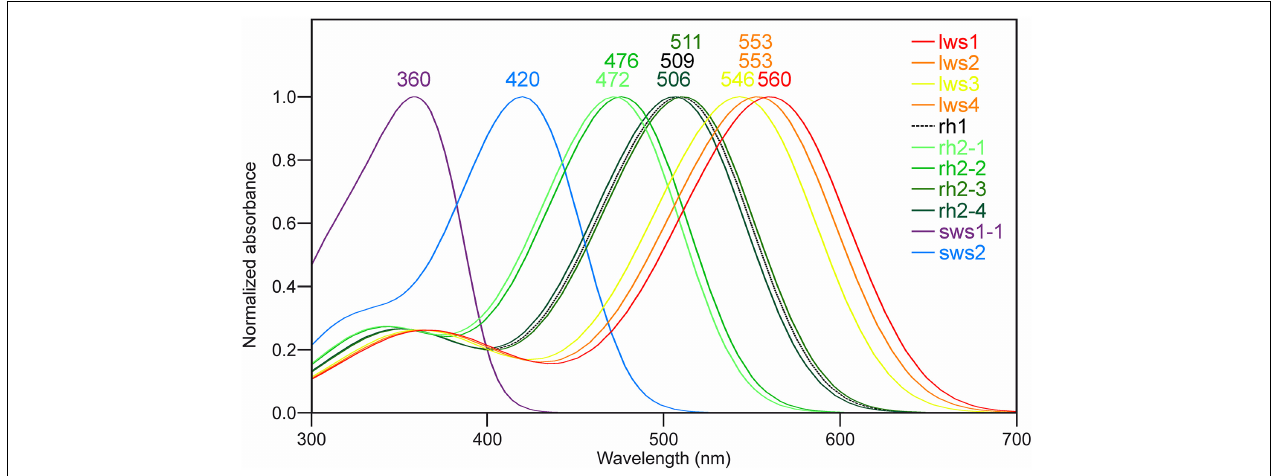
FIGURE 2 | Predicted spectral peaks of absorbance for Atlantic salmon visual photopigments. The schematic shows predicted λ max values using normalized A 1 -based rhodopsin templates (Govardovskii et al., 2000) as follows: Sws1 = 360 nm; Sws2 = 420 nm; Rh2-1 = 472 nm; Rh2-2 = 476 nm; Rh2-3 = 511 nm; Rh2-4 = 506 nm; Lws1 = 560 nm; Lws2 = 553 nm; Lws3 = 546 nm; Lws4 = 553 nm, as well as Rh1 = 509